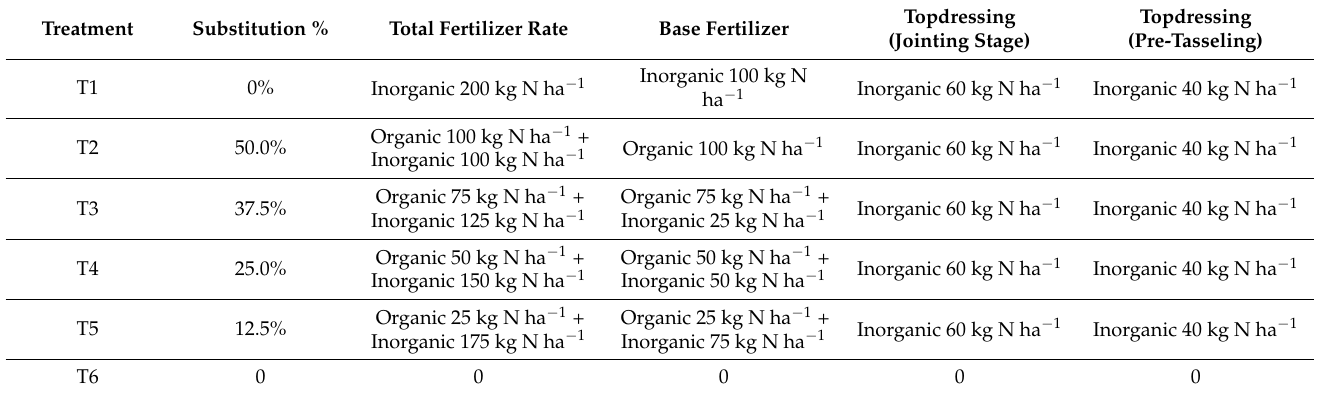
Table 2. Different treatments of nitrogen fertilizers.